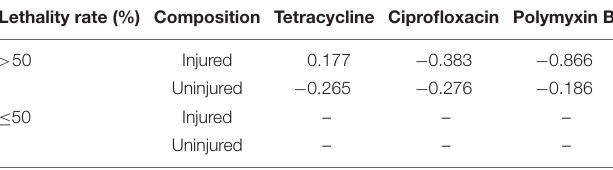
TABLE 1 | Spearman’s correlations between bacterial composition during UV exposure and MICs of antibiotics against them.